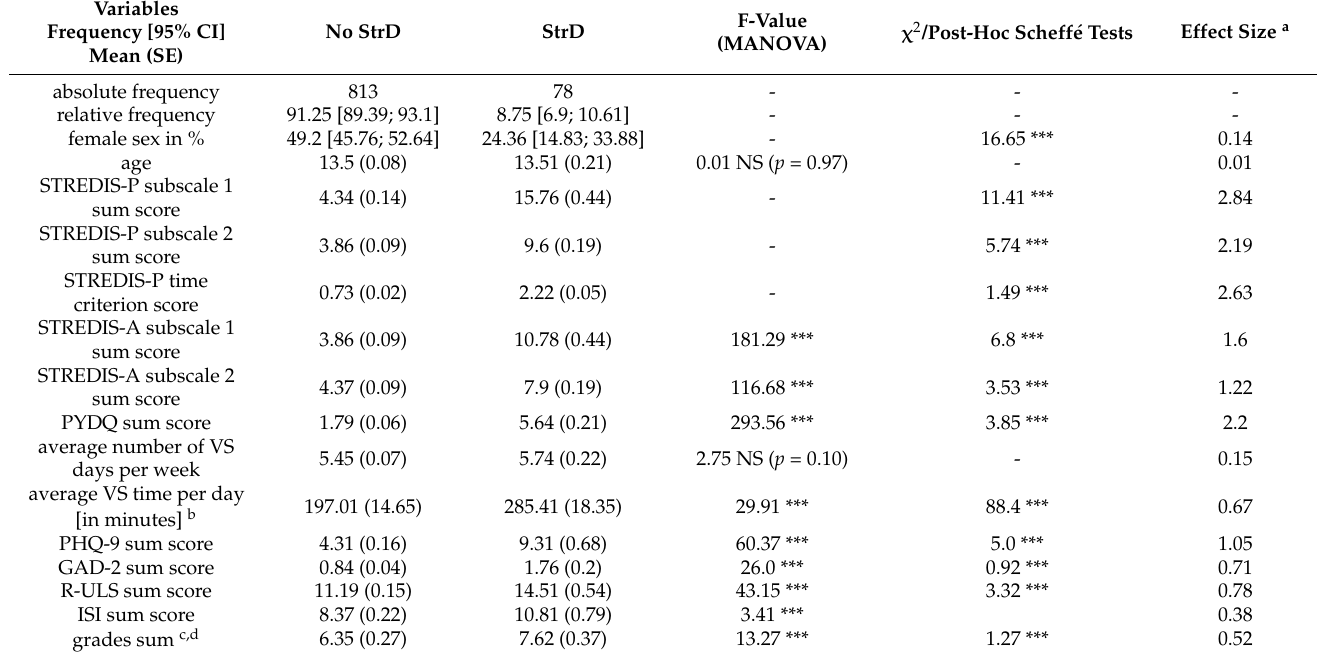
Table 5. Frequencies and statistical comparisons of adolescents with and without